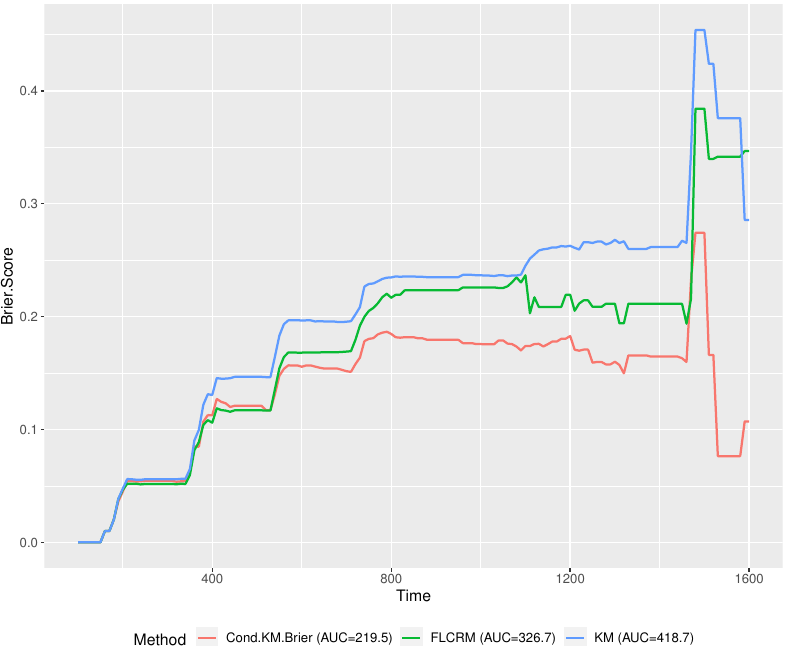
Figure 3. Brier scores on the ADNI data for different methods: Cond.KM.Brier = Conditional Kaplan– Meier (Bandwidth selection based on Brier scores), KM = Kaplan–Meier and FLCRM = Functional Linear Cox Regression